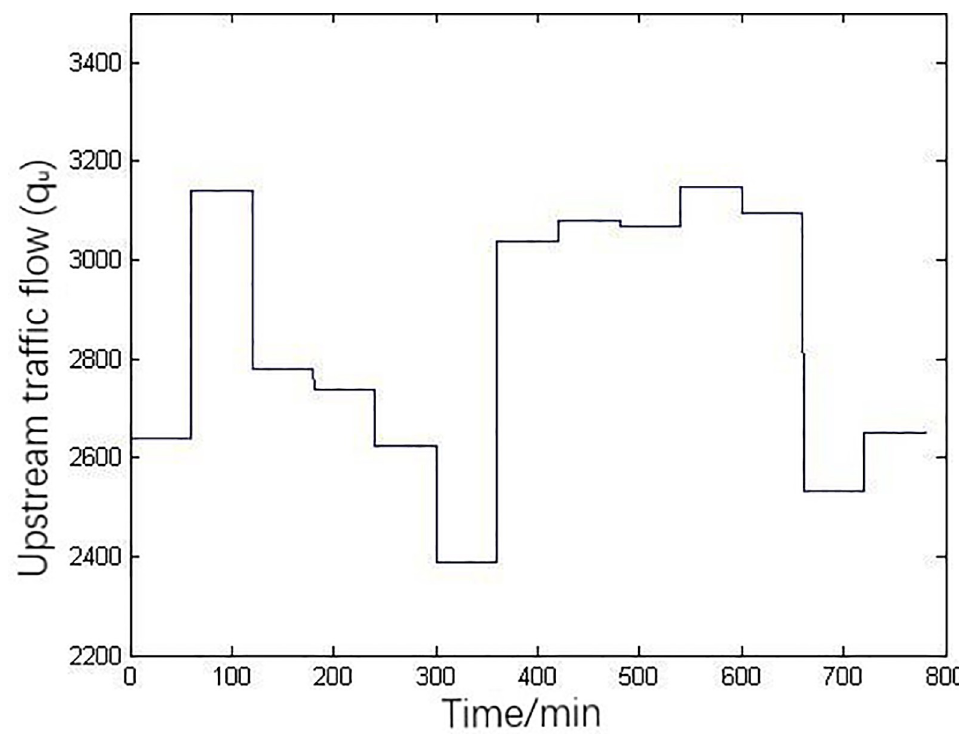
Fig 4. The actual flow variation input of